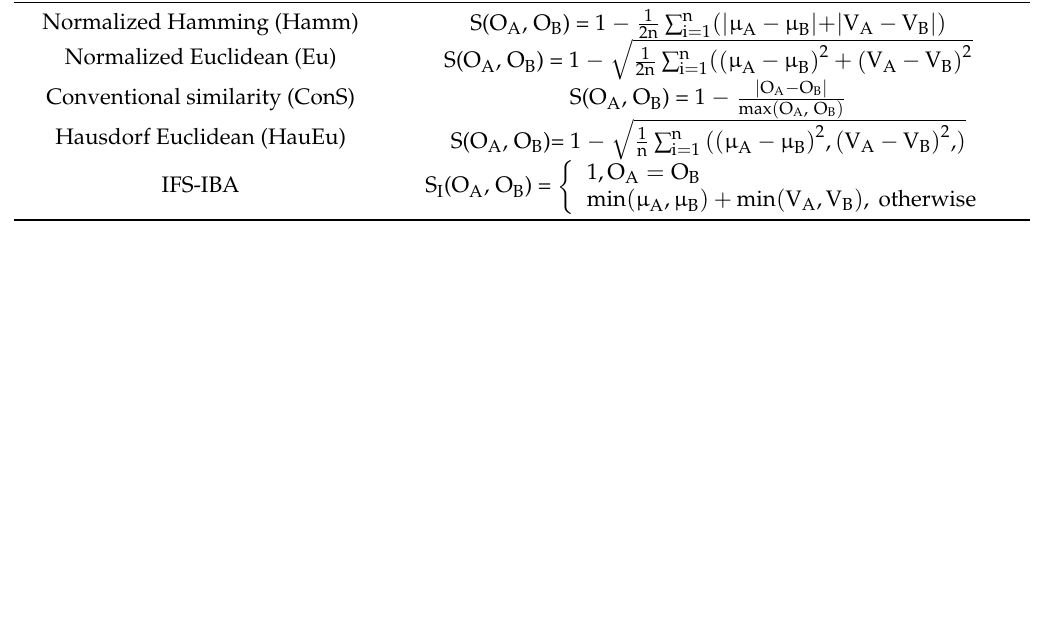
Figure 8. Clustering results in experimental region a .